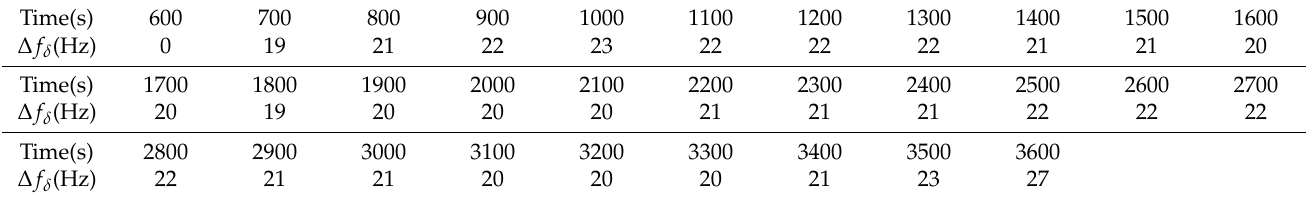
Table 4. Frequency fluctuations test data of low-pass filter output from 600 s to 3600 s when F = 90 cN (the group where the greatest fluctuation occurred, and the red color is the maximum data for this group of